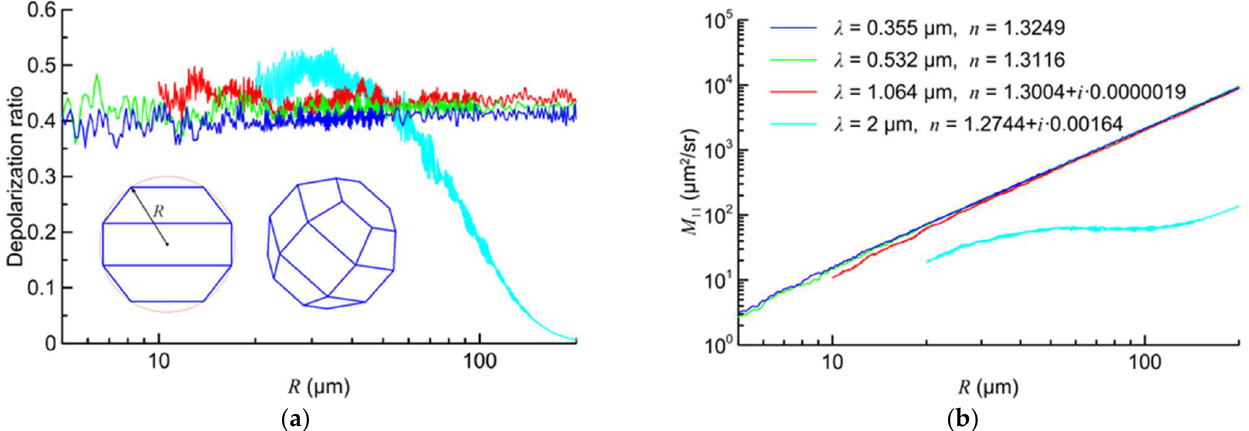
Figure 1. Depolarization ratio δ ( a ) and backscattering cross section M 11 ( b ) for droxtals at the conventional lidar wavelengths.